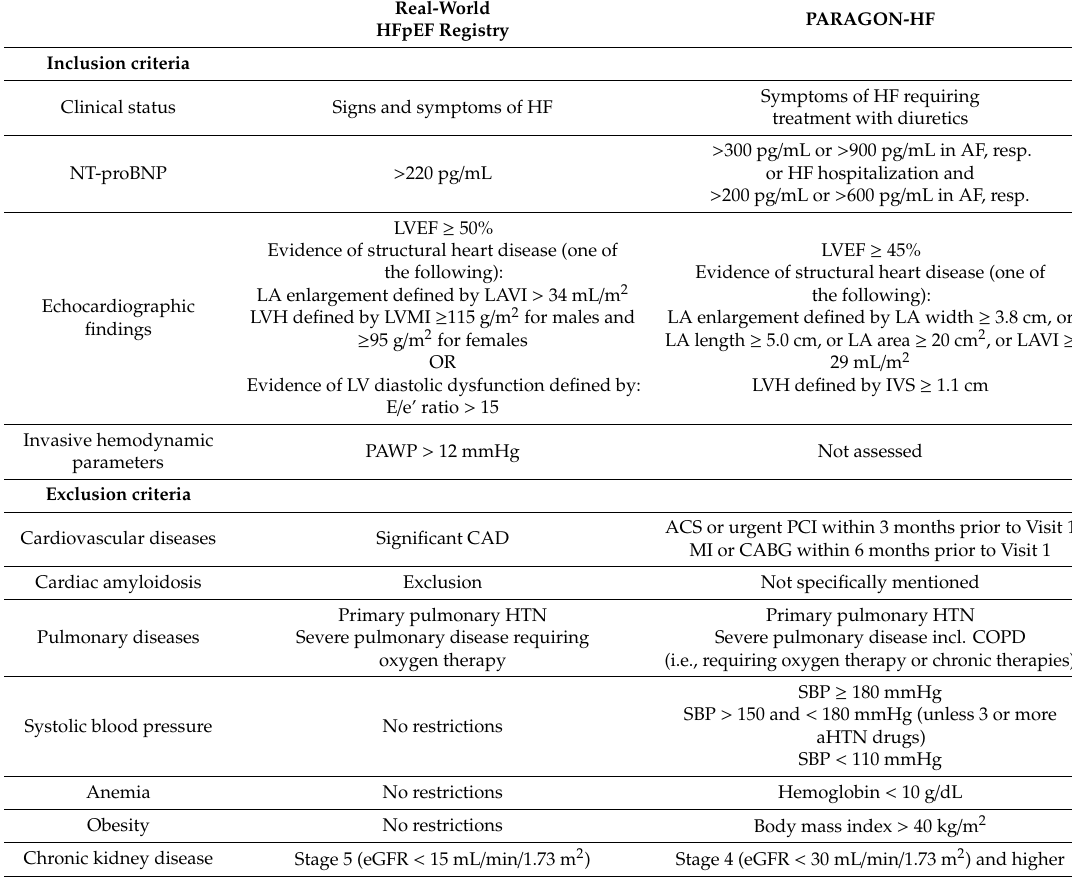
Table 1. Comparison of most relevant di ff erences in inclusion and exclusion criteria between